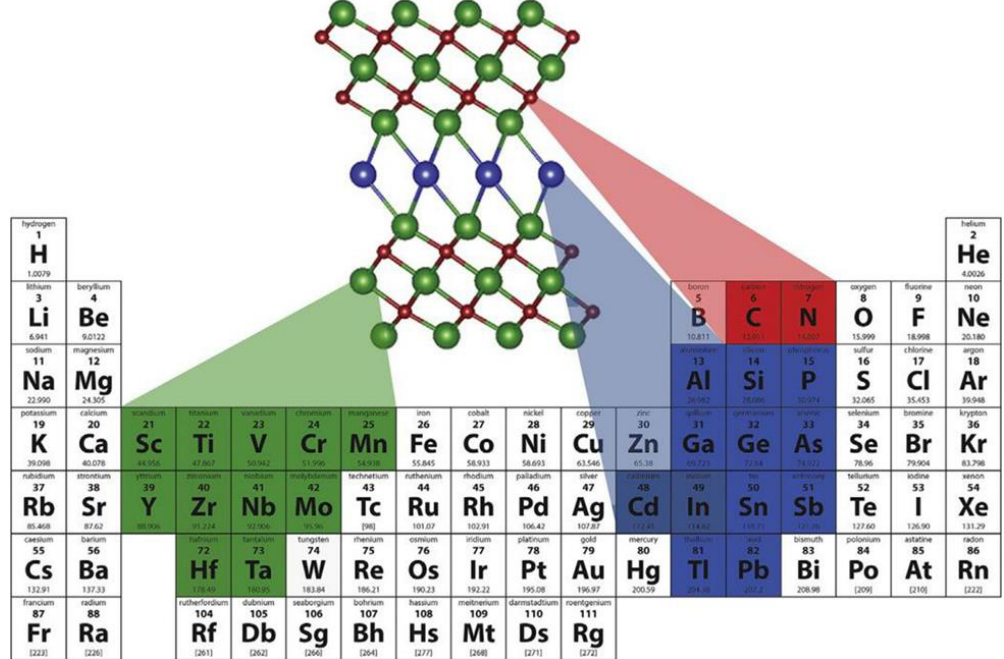
Figure 2. MXene phases M n+1 AX n -producing elements (Reprinted with permission from Ref. [20]. 2019 Elsevier).